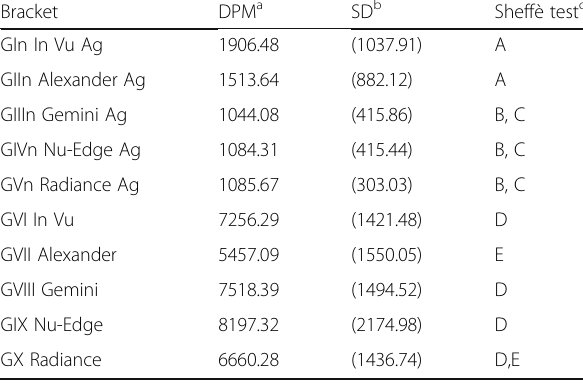
Table 2 Quantitative test to S. sobrinus by radiolabeled ( 3 H)